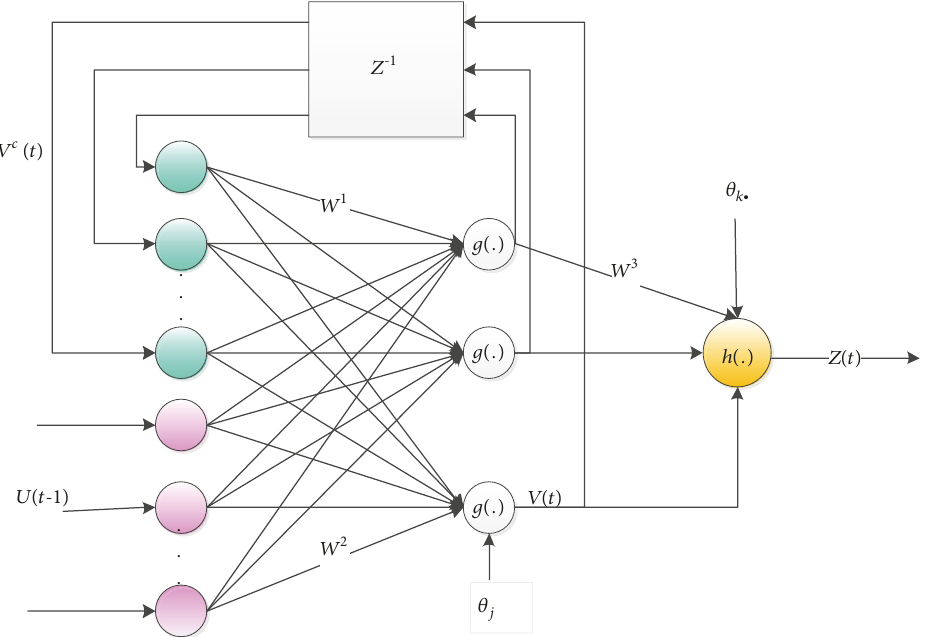
Figure 1: Elman neural network